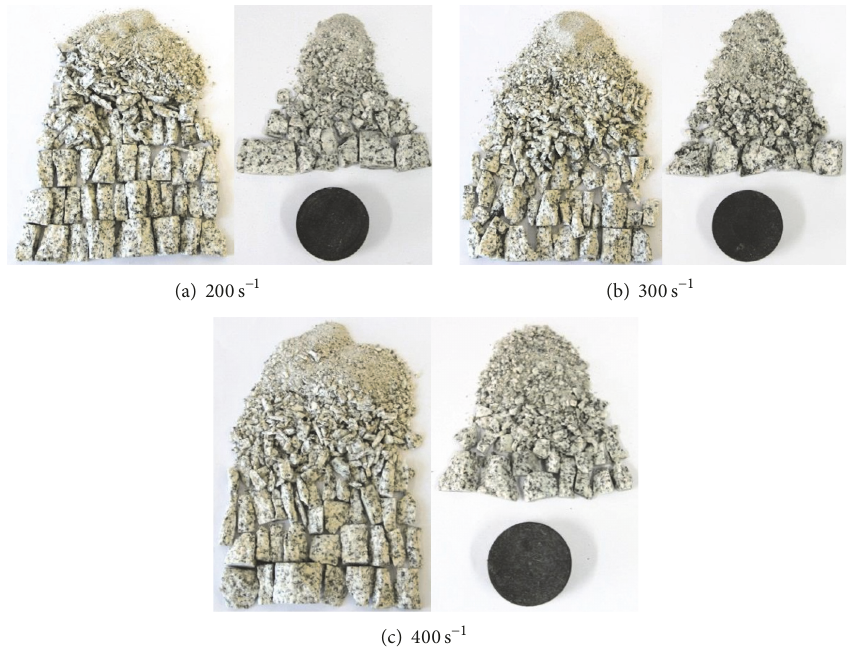
Figure 13: Physical photos of cracked samples under strain rates.